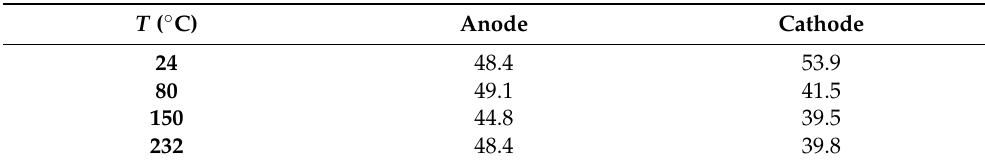
Table 3. The overall porosity (volume %) of the uncalendered graphite anodes and NMC cathodes dried at different